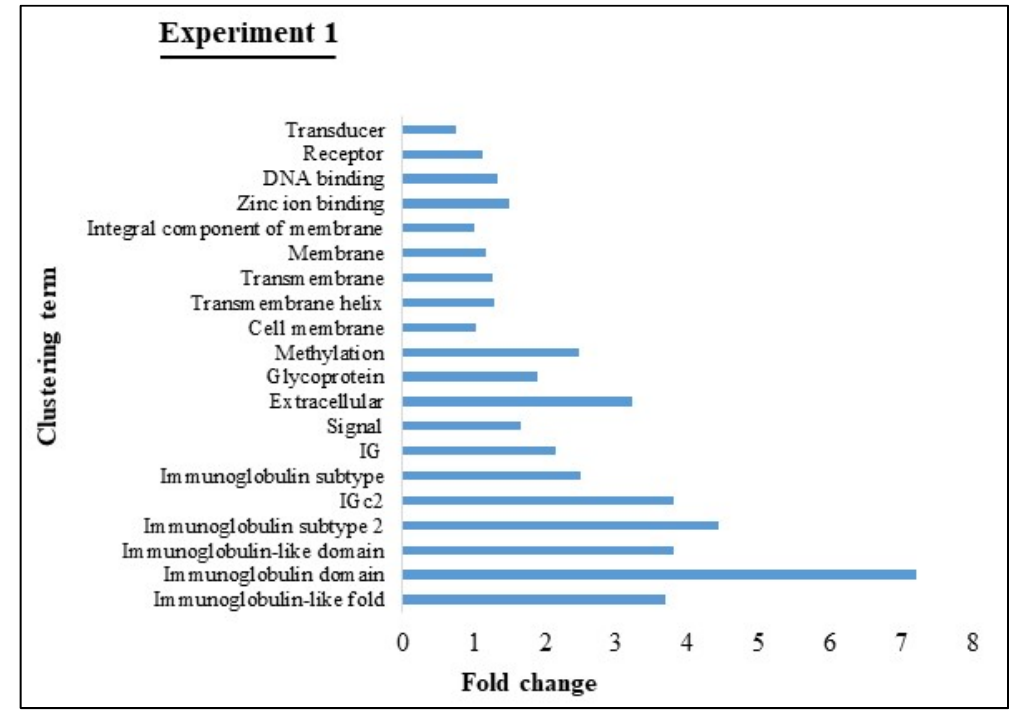
Figure 4. Functional annotation clustering (using DAVID v6.8) of DEGs enriched in milk EVs from BLV-infected cattle with HPL in Experiment 1. (Top 20 with high fold change). X-axis represented fold change and Y-axis represented clustering term. Table 2. Kyoto Encyclopedia of Genes and Genomes (KEGG) pathways (important 10) of DEGs (up- regulated and down-regulated) in milk EVs from BLV-infected cattle with HPL in Experiment 1.